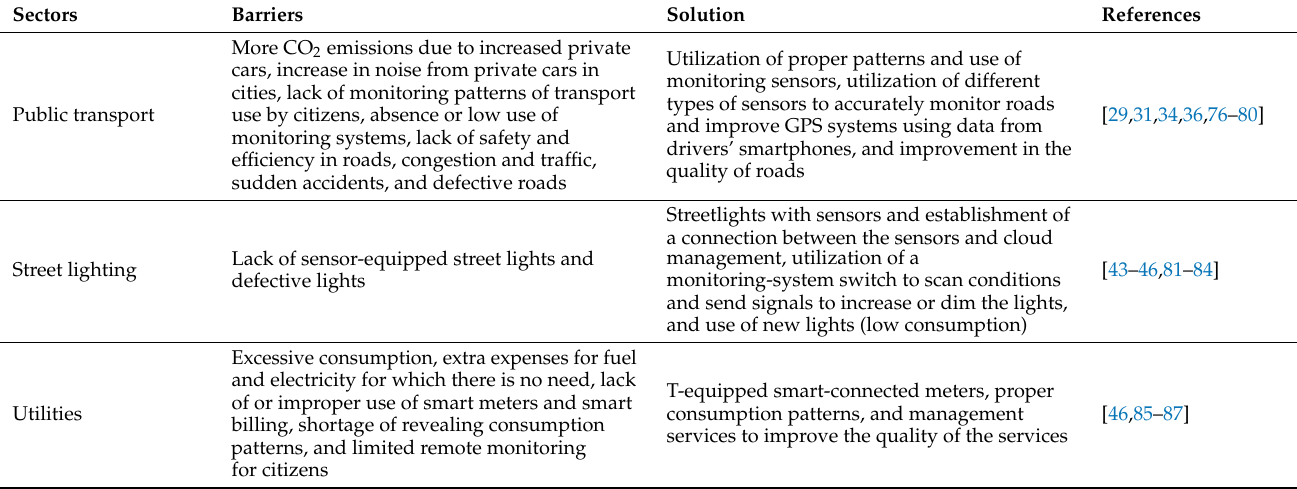
Table 1. The most important barriers related to SC development based on the IoT and the appropriate